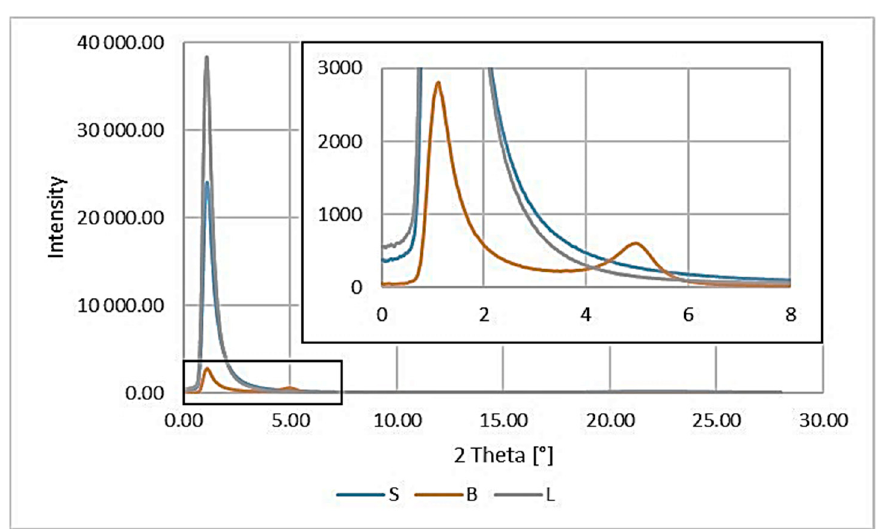
Figure 9. Results of the WAXS study of the fillers used.